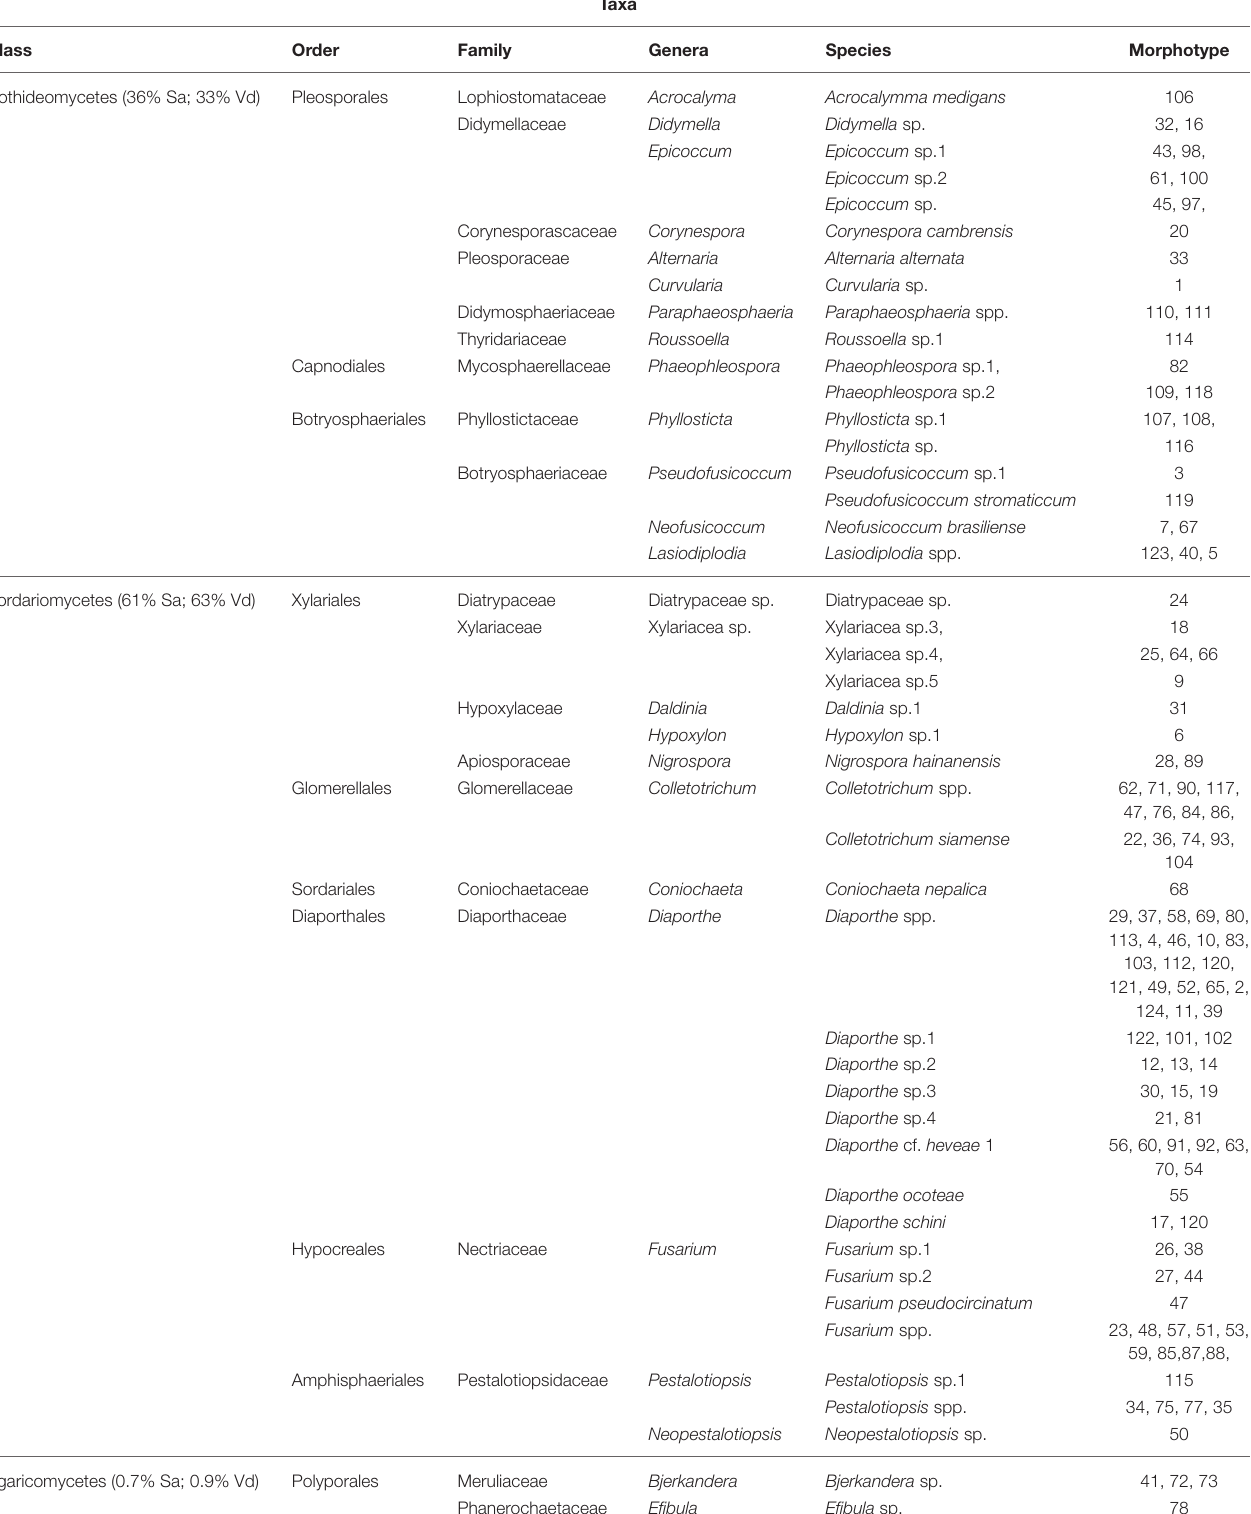
TABLE 1 | Taxonomic classification of endophytic fungi isolated from Stryphnodendron adstringens and Vochysia divergens